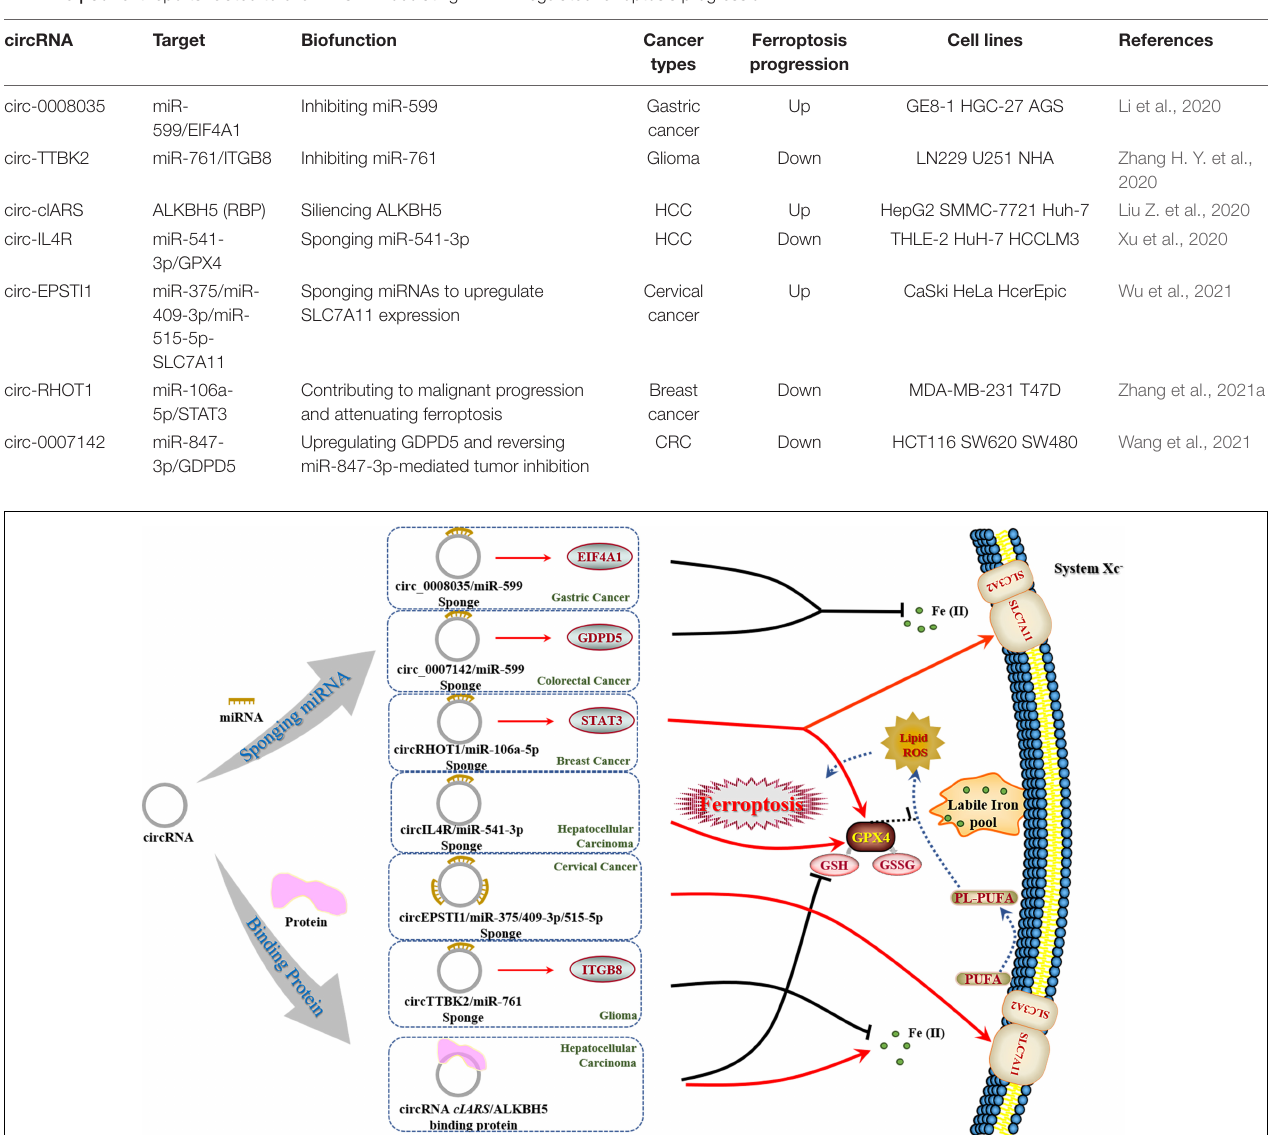
FIGURE 3 | Regulatory effect of circRNAs on ferroptosis in cancers. In the regulation of ferroptosis, circRNAs present two distinct mechanisms based on recent reports. There is only one circRNA (termed cIARS ) that is able to execute ferroptosis in cancer cells as reported. Moreover, cIARS holds novel promise in interacting with proteins, which needs to be deeply addressed for further